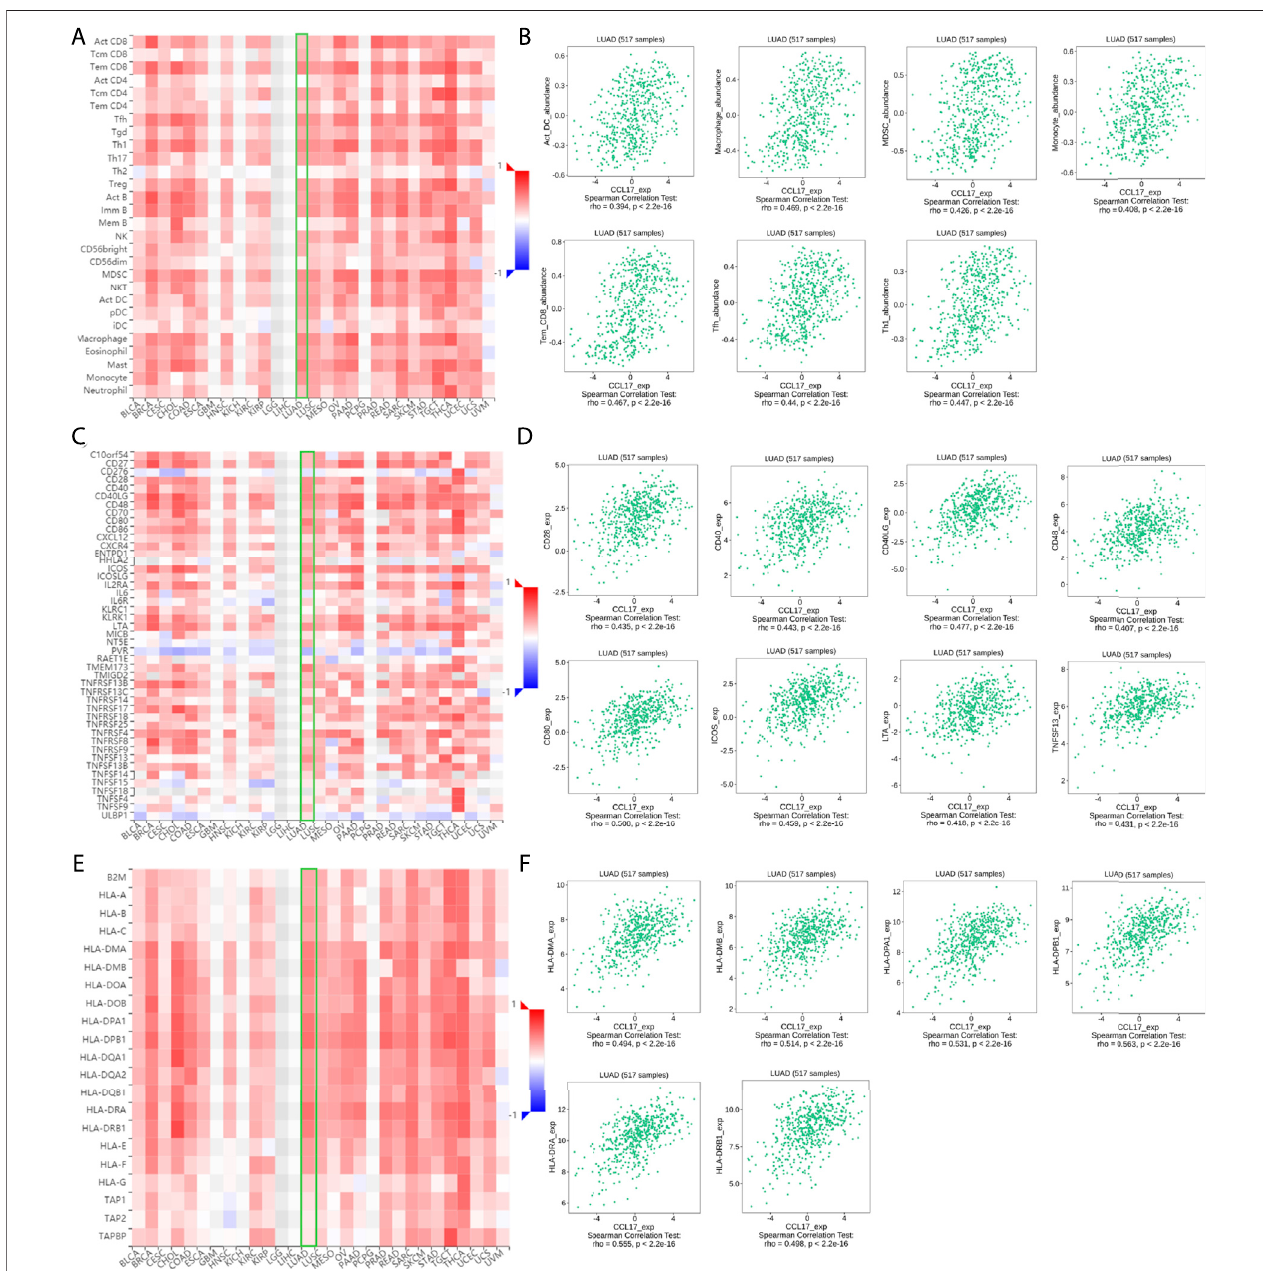
FIGURE3|(A-F) Correlation ofCCL17withTILs,immunostimulators,andMHCs inTISIDB. (A-B) CorrelationofCCL17expressionwith28types ofTILsinLUAD. (C-D) Correlation of CCL17 expression with immunostimulators in LUAD. (E-F) Correlation of CCL17 expression with MHCs in LUAD.